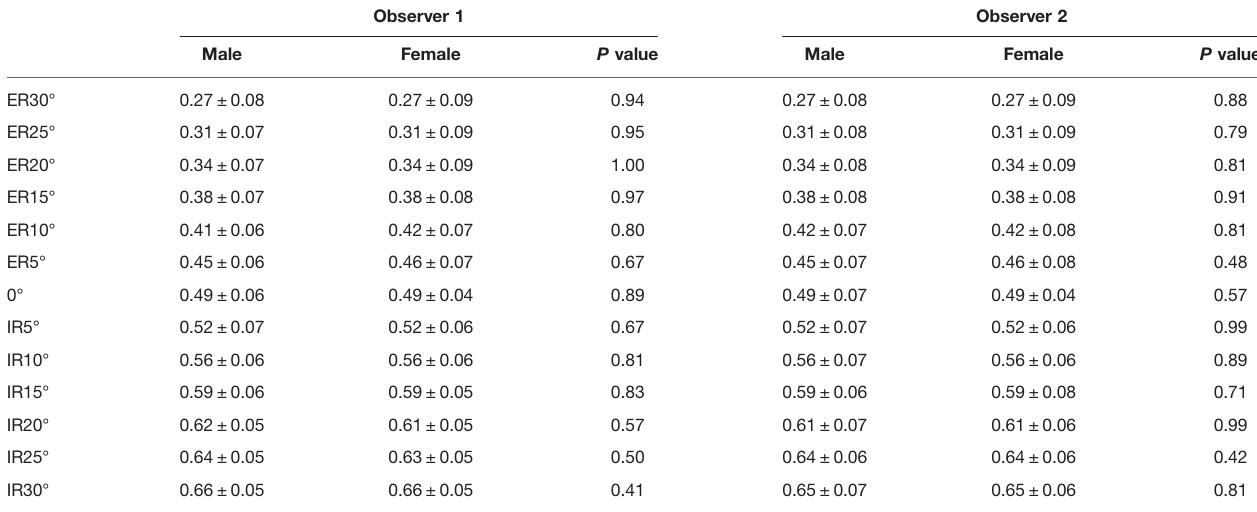
TABLE 3 | Effect of different types of fi bular incisura on ratio α